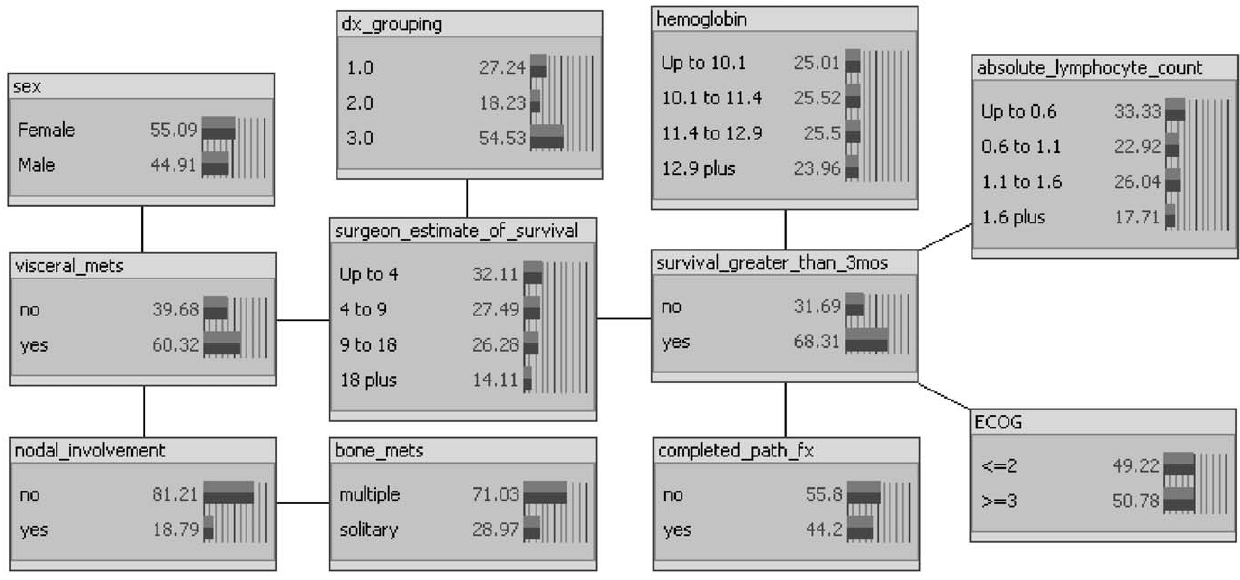
Figure 2. Three-month BBN model with posterior distributions depicted as proportions (%) of the training population. As shown, there are five first-degree predictors of 3-month survival: the surgeon’s estimate of survival (‘‘surgeon_estimate_of_survival’’), preoperative hemoglobin concentration (‘‘hemoglobin’’), preoperative absolute lymphocyte count (‘‘absolute_lymphocyte_count’’), ECOG performance status (‘‘ECOG’’), and the presence of a completed pathologic fracture (‘‘completed_path_fx’’). The network structure indicates that the primary oncologic diagnosis (‘‘dx_grouping’’) and the presence of visceral metastases (‘‘visceral_mets’’) are both first-degree associates of the surgeon’s estimate node.